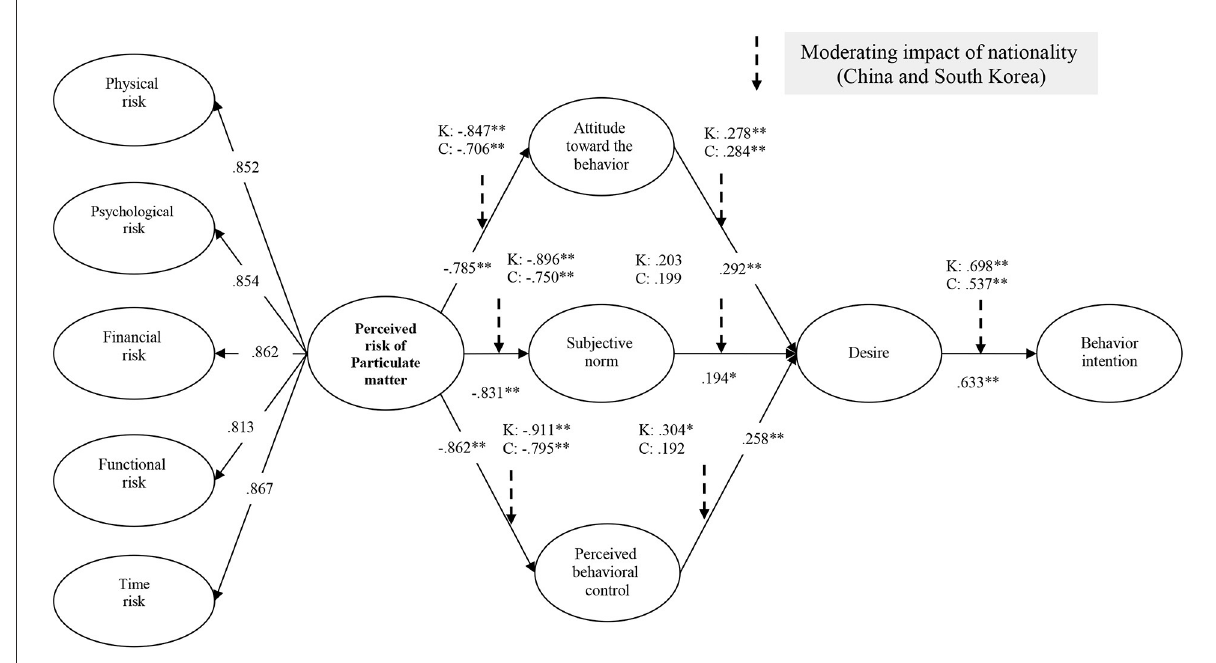
FIGURE2 Results of structural